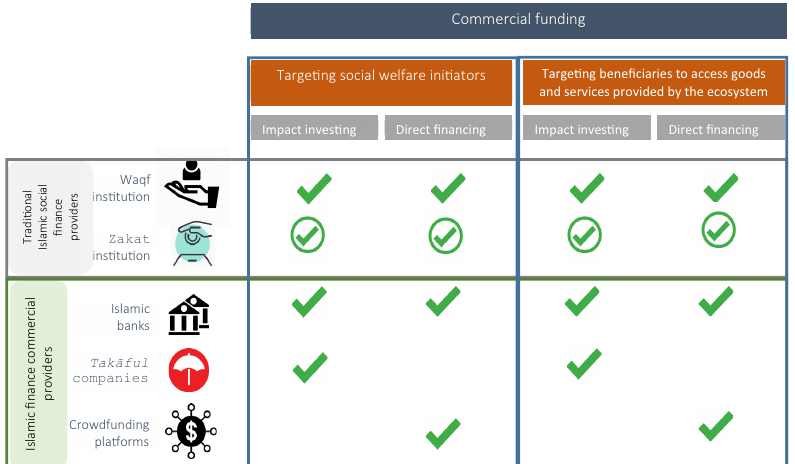
Figure 4. Types of